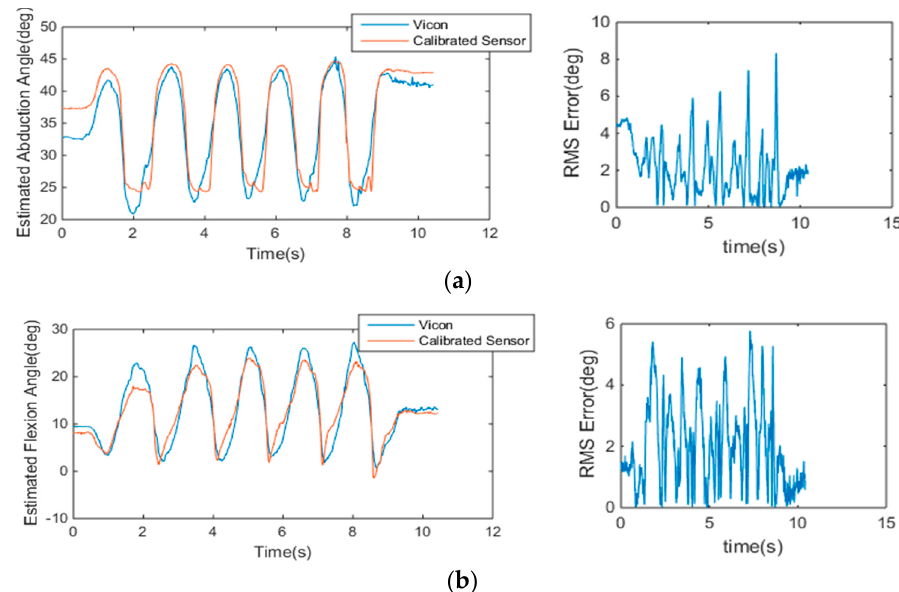
Figure 11. Representative results for response of the calibrated sensor with respect to the CMC-joint angles: ( a ) CMC-joint abduction angle estimated with Vicon and with the calibrated abduction sensor ( left ) and the RMSE of the calibrated abduction sensor with respect to the Vicon results ( right ); ( b ) CMC-joint flexion angle estimated with Vicon and with the calibrated abduction sensor ( left ) and the RMSE of the calibrated flexion sensor respect to the Vicon results ( right ).